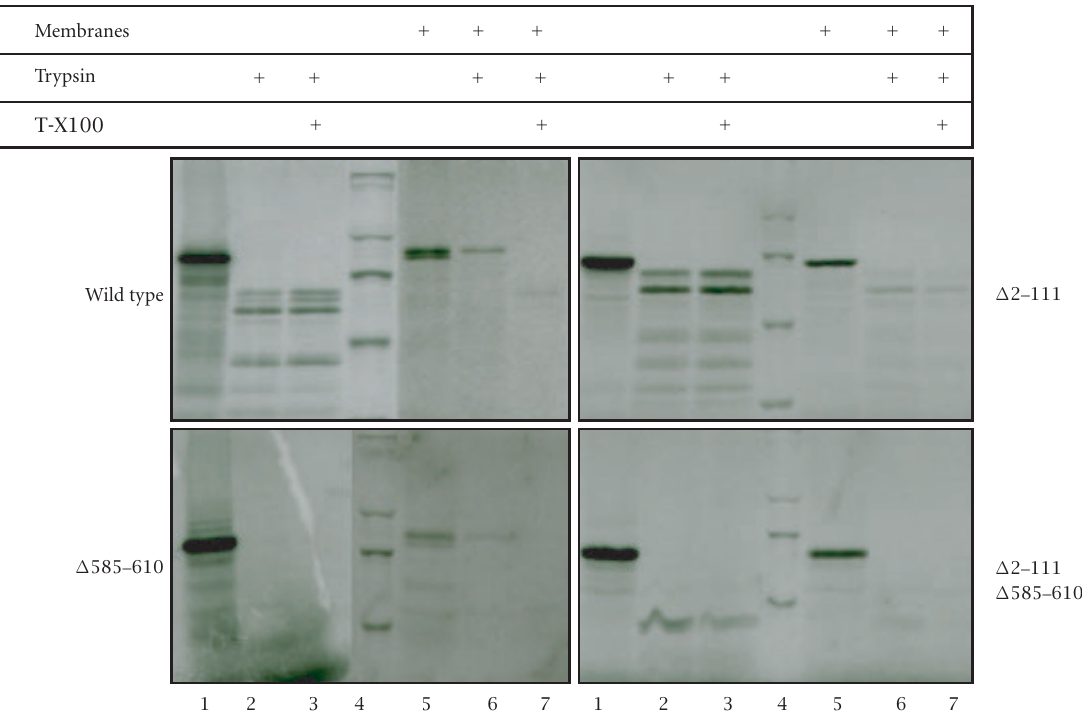
Figure 5:Wild type or mutant ORF 2 proteins were synthesized in vitro in the absence (lanes 1 – 3 ) or presence (lanes 5 – 7 ) of canine pancreatic membranes. Subsequently, each reaction mix was divided into three parts, treated with trypsin and Triton-X 100 as shown and analyzed on reducing SDS- 7 . 5 % polyacrylamide gels. Molecular size markers (lane 4 ) are, from top to bottom, 200 kDa, 97 . 4 kDa, 66 kDa, and 46